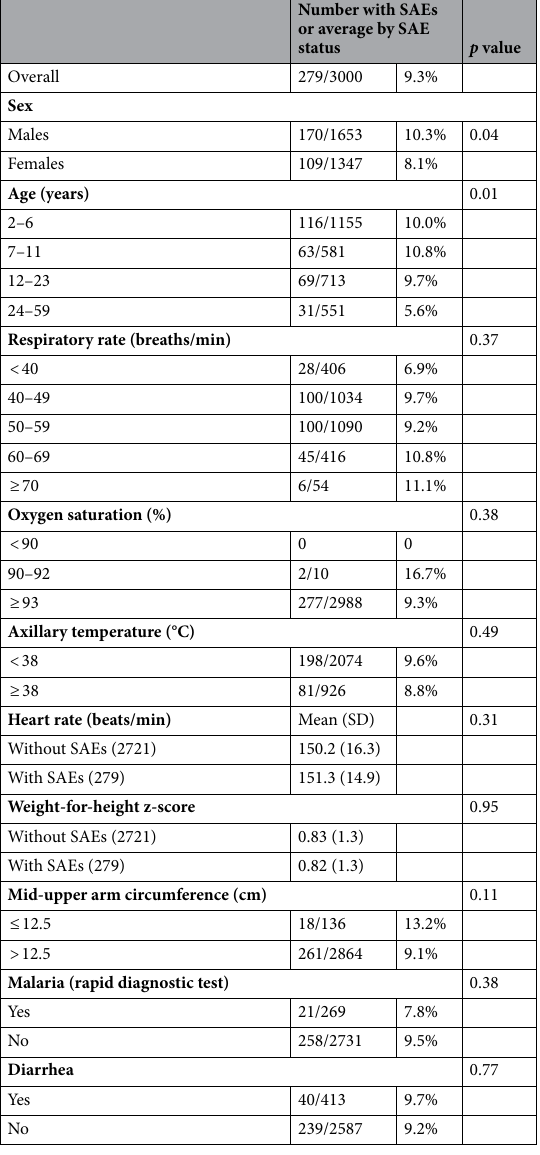
Table 1. Number of children for whom serious adverse events (SAEs) were reported by baseline